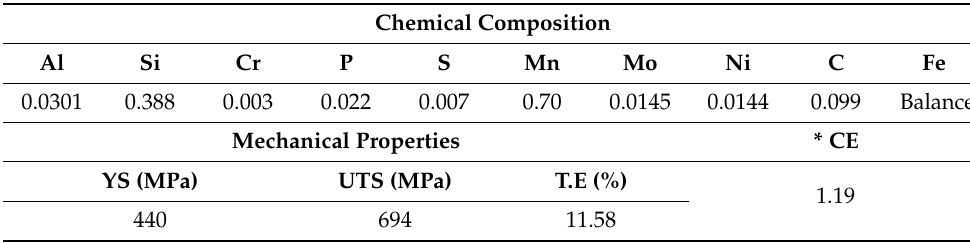
Table 1. Mechanical properties, chemical composition and carbon equivalent (CE) of investigated steel. (Reprinted from [26] with permission from Elsevier) Chemical Composition Al Mechanical